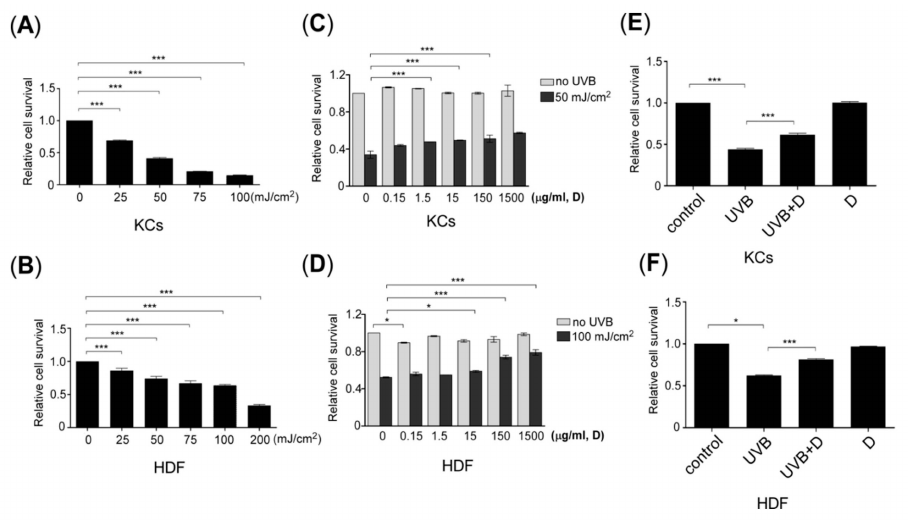
Figure 1. Derinat protected skin cells from UVB damage. The effect of UVB irradiation on cell viability in ( A ) keratinocytes (KCs) and ( B ) human dermal fibroblasts (HDF) ( *** , p < 0.001). The cell survival probability for cells pretreated with different concentrations of Derinat for 24 h and irradiated with or without UVB-exposure in ( C ) KCs and ( D ) HDF ( * , p < 0.05; *** , p < 0.001). Further confirming the result of ( C , D ), in ( E ) KCs and ( F ) HDF were pretreated with 15 µ g and 150 µ g of Derinat and irradiated with 50 mJ/cm 2 and 100 mJ/cm 2 UVB, respectively. The cell survival probability was analyzed using an MTT assay after 24 h of UVB-exposure ( * , p <0.05; *** , p